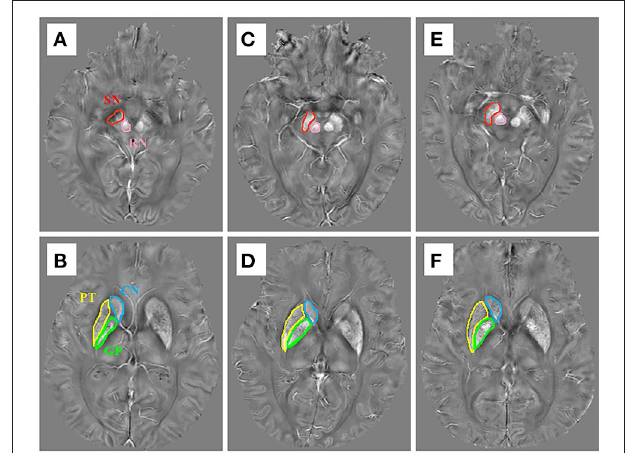
FIGURE 1 | The susceptibility maps illustrate the five regions of interest in (A,B) a control case, (C,D) an early stage of PD case, and (E,F) a late-stage of PD